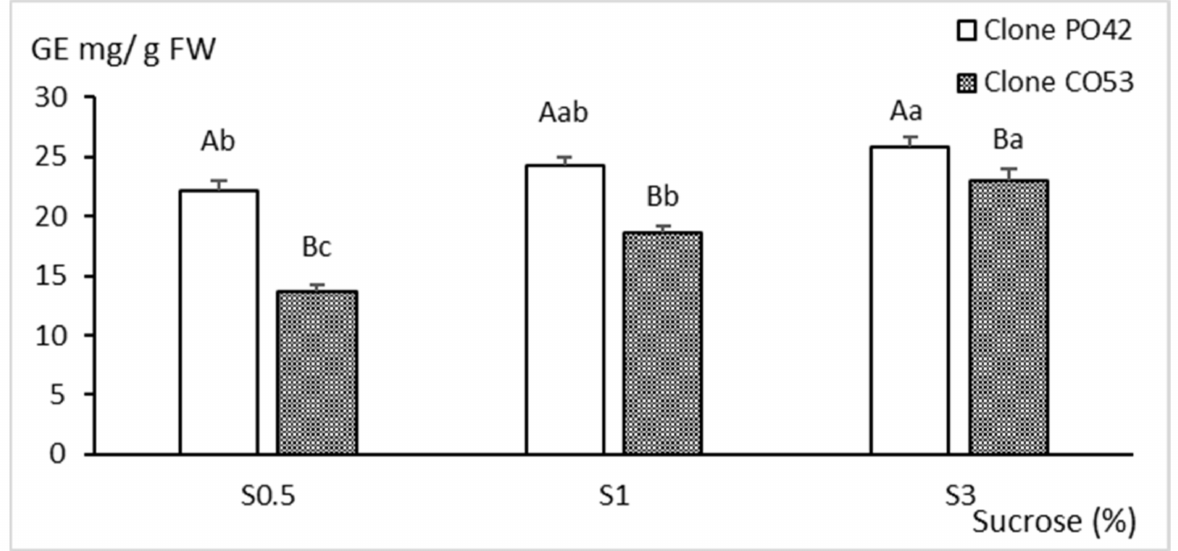
Figure 6. Effect of sucrose supplementation on monosaccharide content of shoots of clones PO42 and CO53 cultured by temporary and continuous immersion, respectively. Values are the mean ± standard error from 24 shoots analyzed independently. Different capital letters indicate significant differences in relation to the genotype, and different lowercase letters indicate significant differences in relation to the sucrose supplementation ( p < 0.05). GE, Glucose